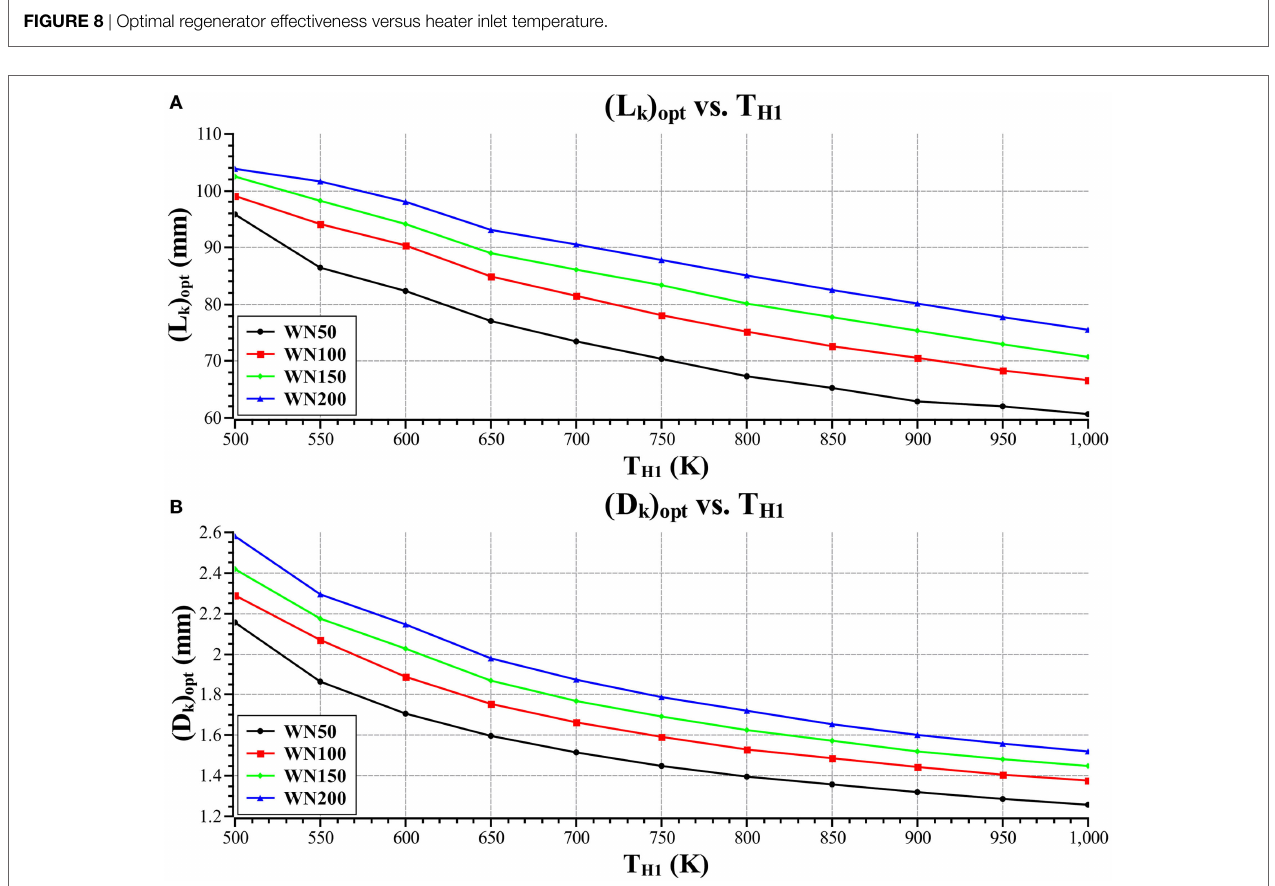
FIGURE 9 | Optimal (A) cooler tube length and (B) diameter versus heater inlet temperature.